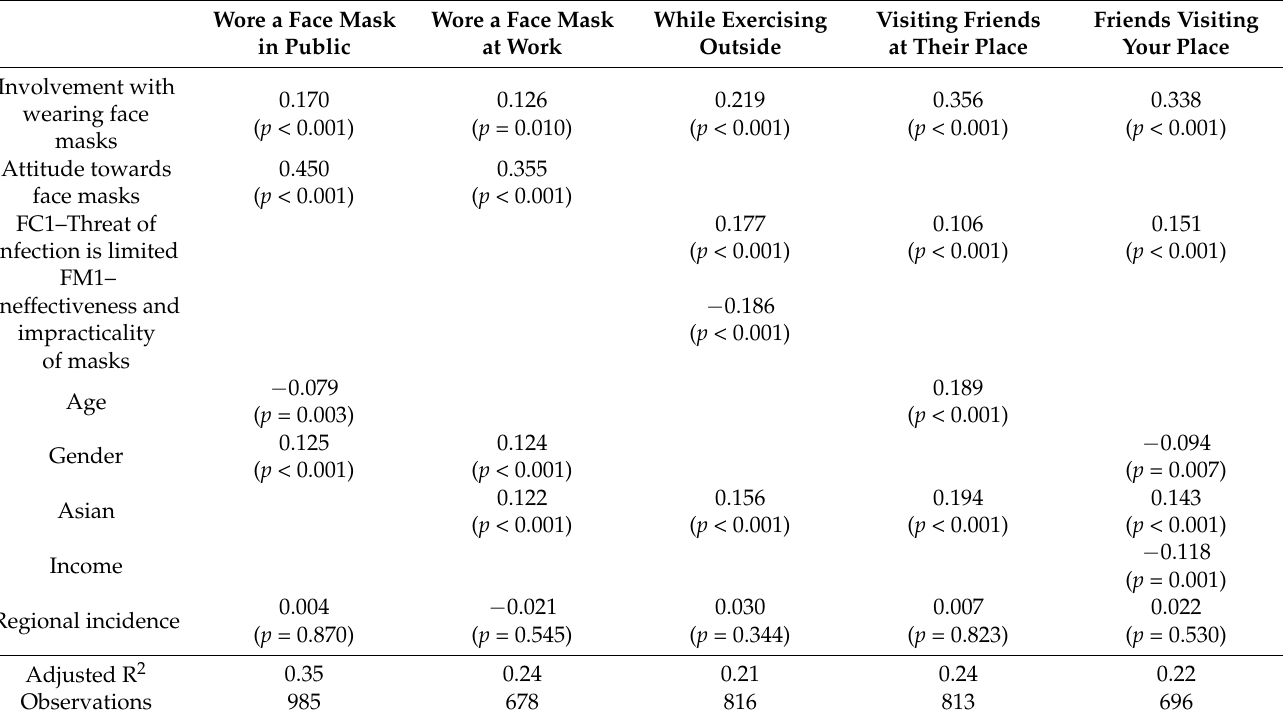
Table A2. Standardised parameter estimates from regressions for wearing face masks including regional incidence of COVID-19